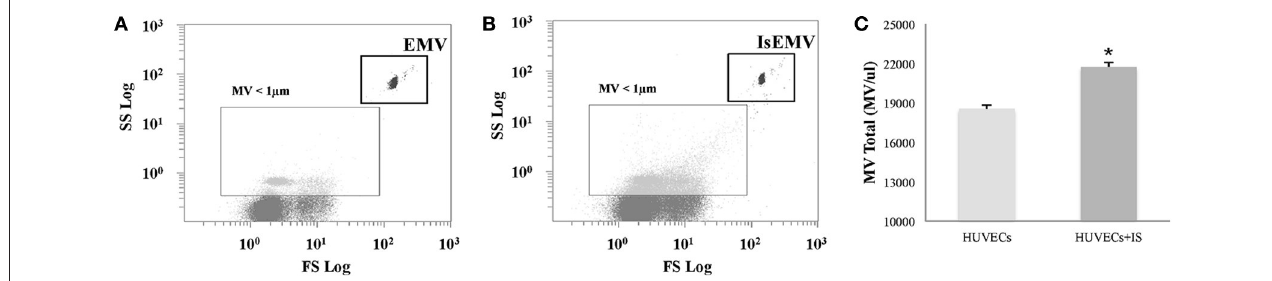
FIGURE 2 | Human Umbilical Vein Endothelial Cells (HUVECs)-derived microvesicles (MV) assessed by flow cytometry. (A) Representative dot plot showing log forward scatter (FSC) vs. log side scatter (SSC) localization of MV. The upper right gate shows the bead flow count, used as an index to count MV in absolute terms. The lower left gate shows MV smaller than 1 µ m. (B) Representative dot plot showing localization of MV derived from IS-treated HUVECs. (C) Absolute number of MV per microliter in IS-treated and untreated HUVECs. Results are the mean ± SEM of five independent experiments. * p < 0.001 vs. MV derived from untreated HUVECs (EMV).